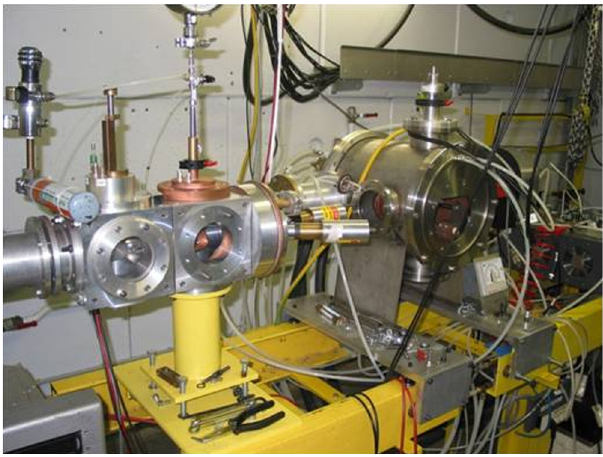
FIG. 15. The 8 (cid:8) LP experiment used for measurement of the 7 Li ð d; p Þ 8 Li cross section.